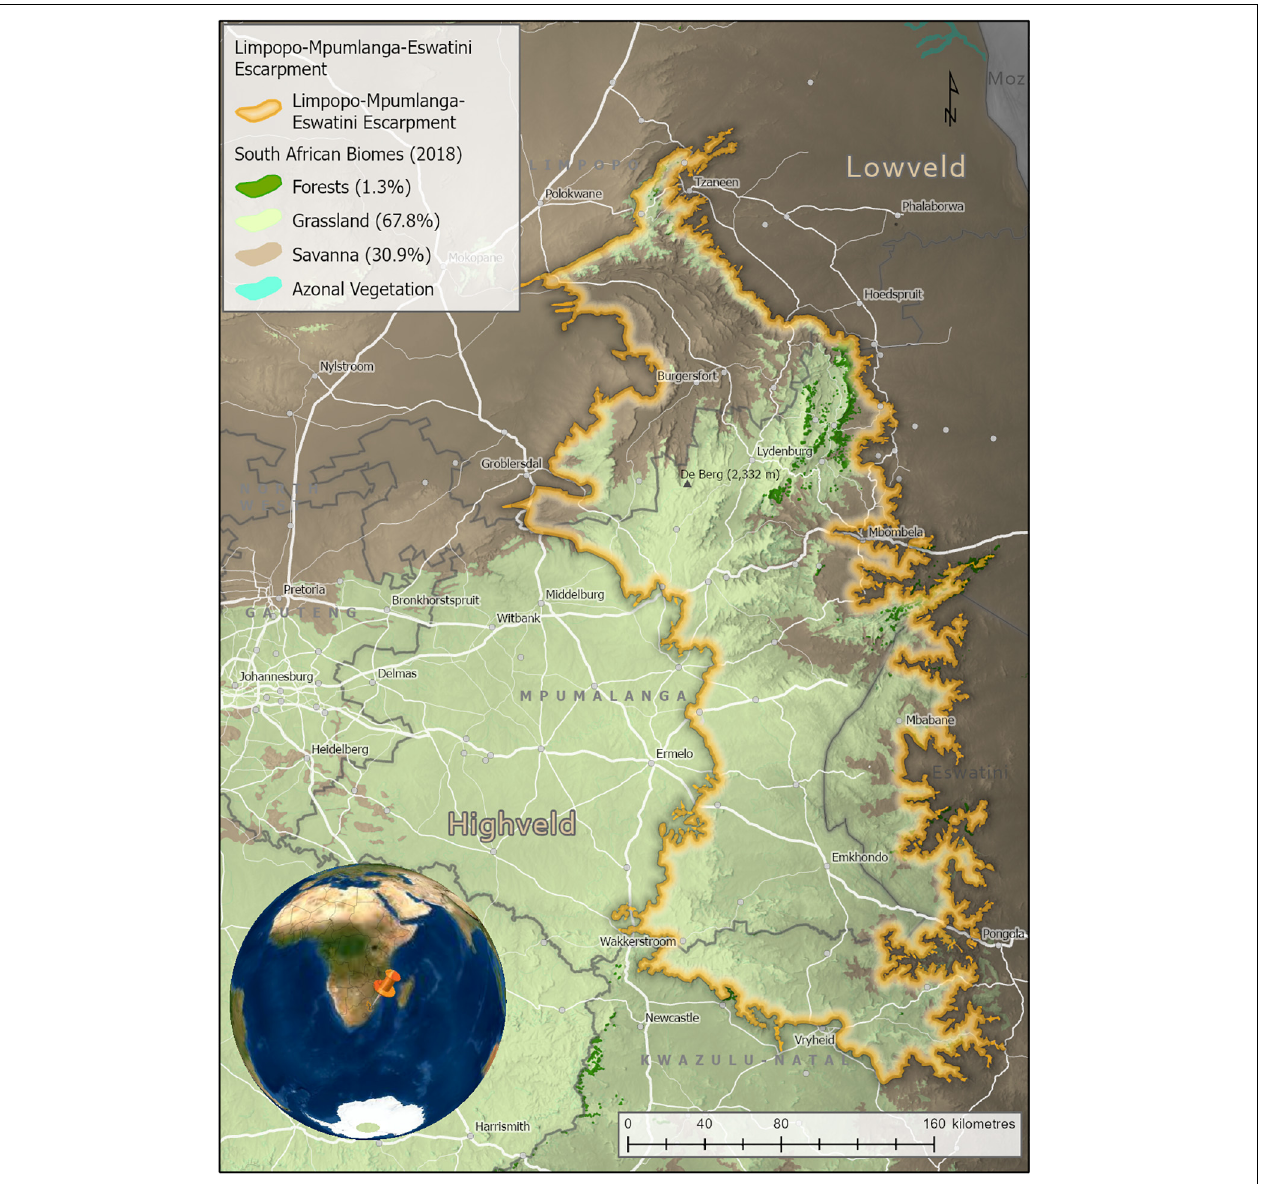
FIGURE 1 | The Limpopo–Mpumalanga–Eswatini Escarpment (LMEE), South Africa, and Eswatini, showing key cadastral features and Biomes (percentages are of the total LMEE area). Biomes derived from the Vegetation of South Africa, Lesotho, and Swaziland (Mucina and Rutherford, 2006). Elevation values are displayed in dark (lower elevations) to light shading (higher